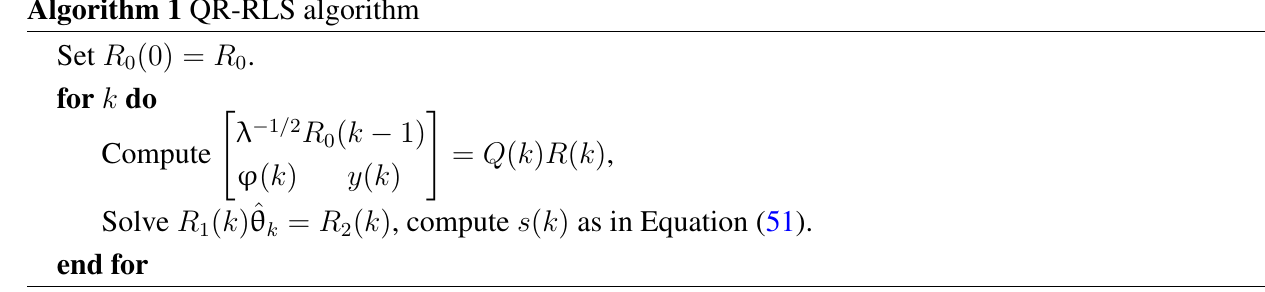
Algorithm 1 QR-RLS